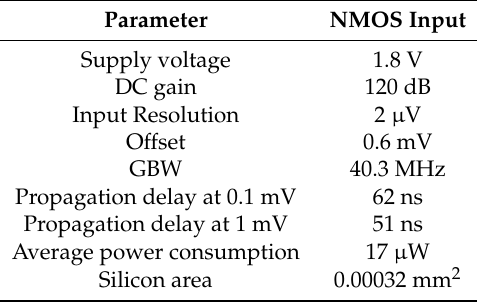
Table 2. Characteristics of